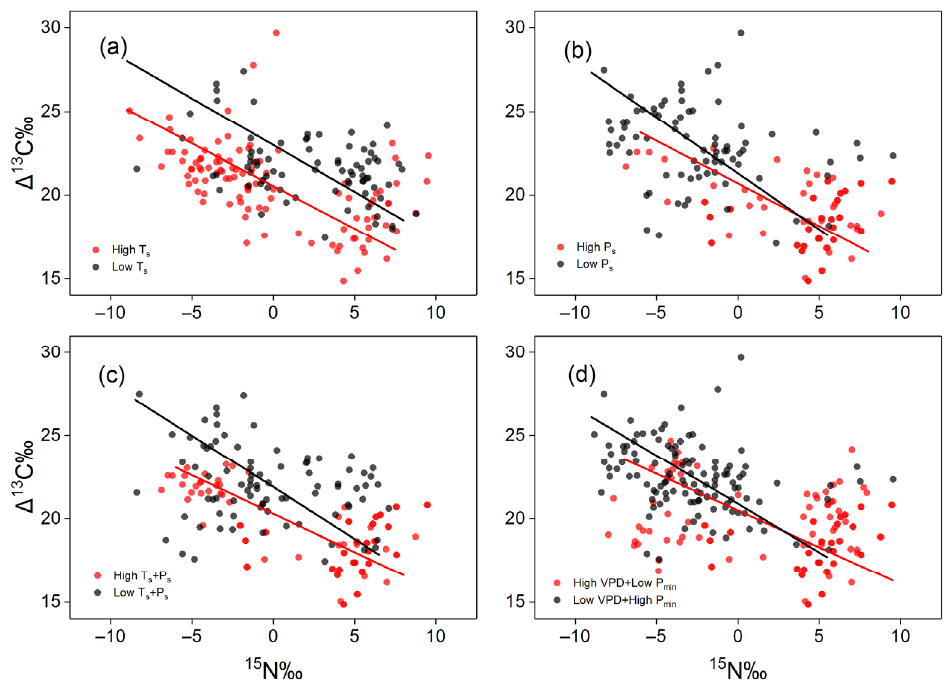
Figure 3. SMA estimation of driving intensity and direction of foliar Δ 13 C and δ 15 N signals by climate seasonality. Seasonality of temperature (( a ), Ts), precipitation (( b ), Ps), temperature and precipitation (( c ), Ts and Ps) and relative evaporative demand correspond to precipitation (( d ), VPD and P min ) all classified into high and low groups. Red dots/lines and black dots/lines represent high and low seasonality, respectively. Table 2. Summary of SMA regression estimated the driving intensity and direction of foliar ∆ 13C and δ 15N signals by climate